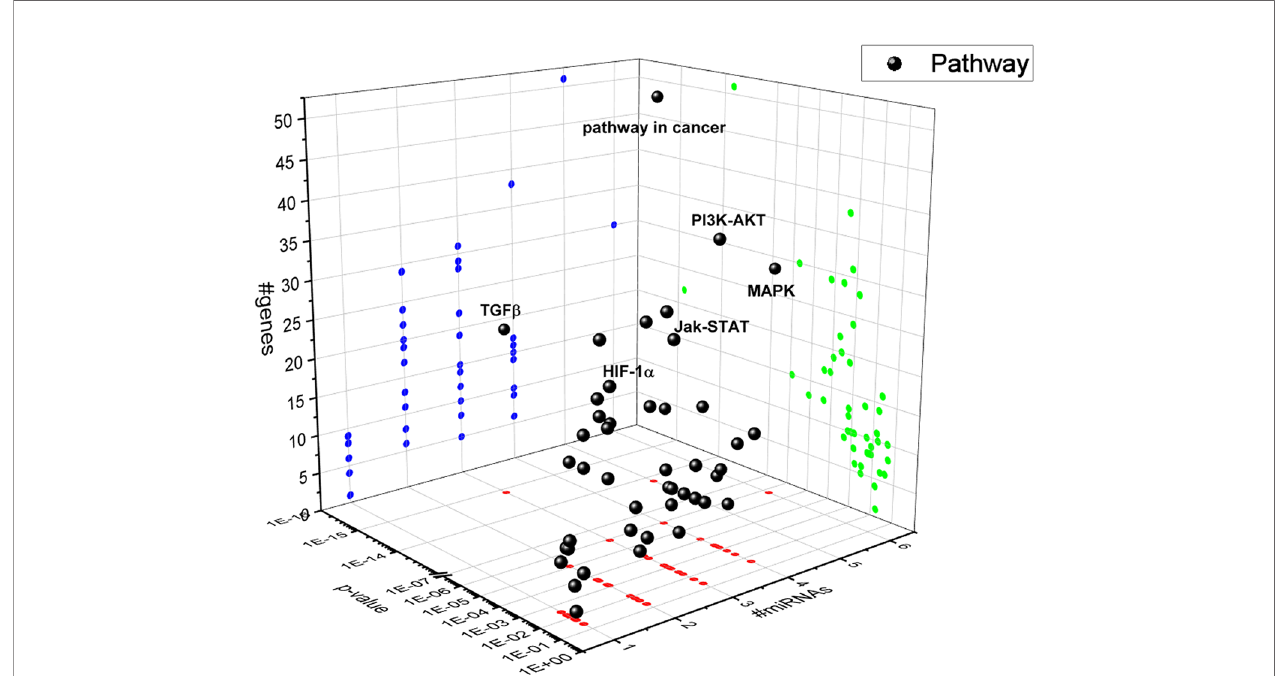
FIGURE 4 | 3D scatter plot of pathways regulated by HypoxamiRs in human retinal endothelial cells (HRECs), challenged with CoCl 2 . Blue dots represent #gene projection of #miRNAs dimension. Green dots represent p-value projection of #genes dimension. Red dots represent #miRNA projection of p-value dimension.